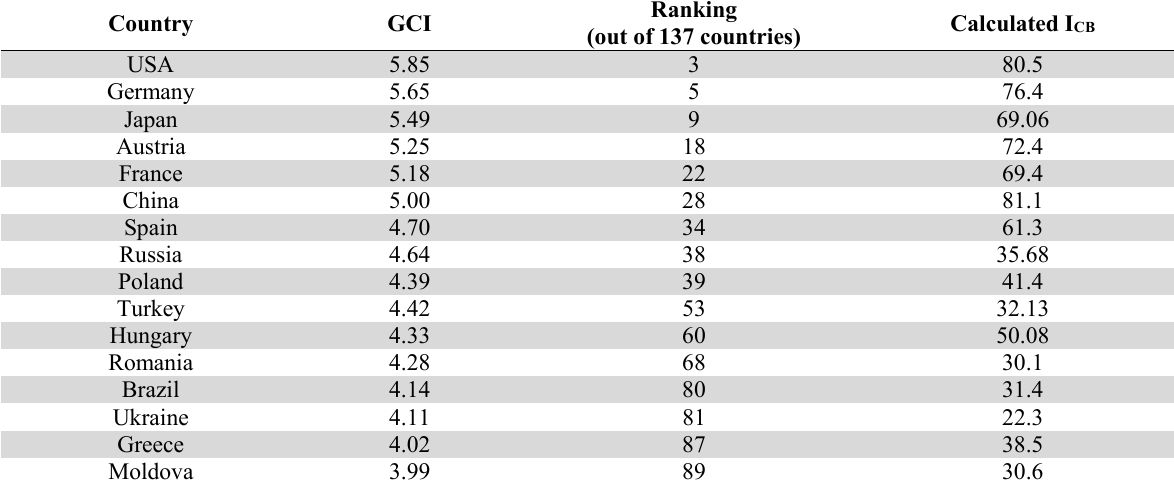
The value of the Global Competitiveness Index (GCI) and the Calculated Country Brand Index (2017) (Schwab (2017) and calculated by the author)